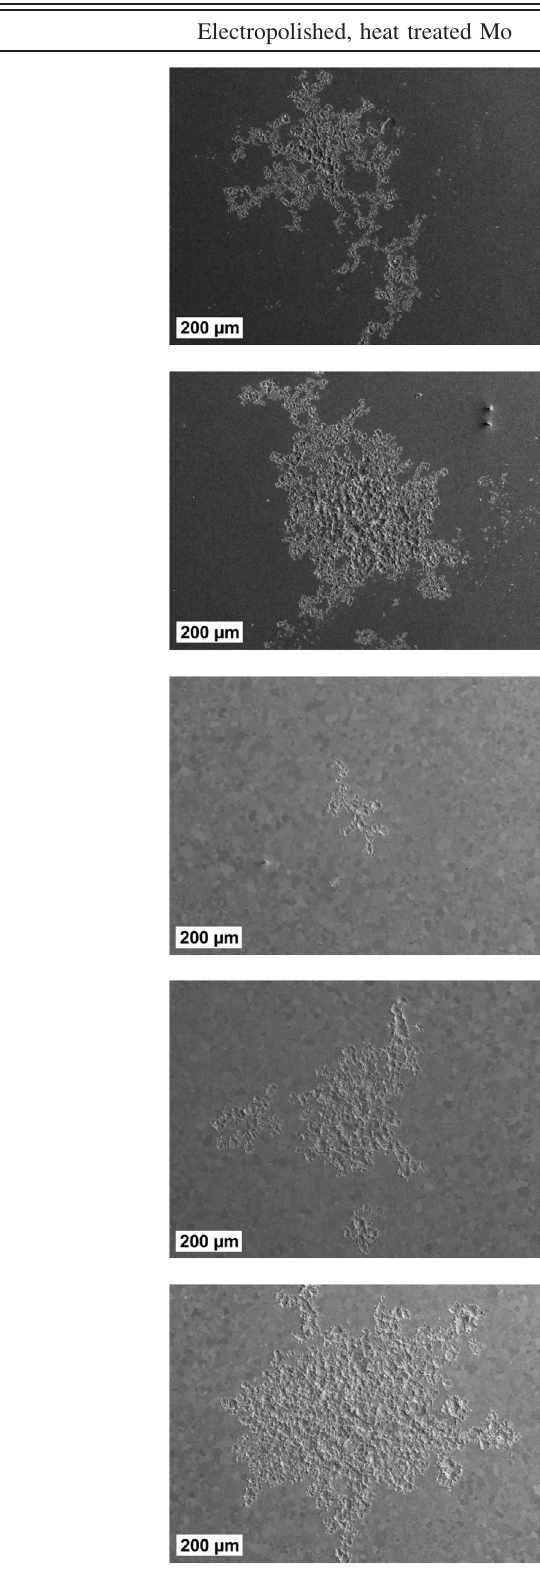
TABLE II. SEM photographs of the development of Mo spot size as a function of sparks on two samples with different surface treatments, both measured with C 1 ¼ 27 : 5 nF . Note the different length scales in the